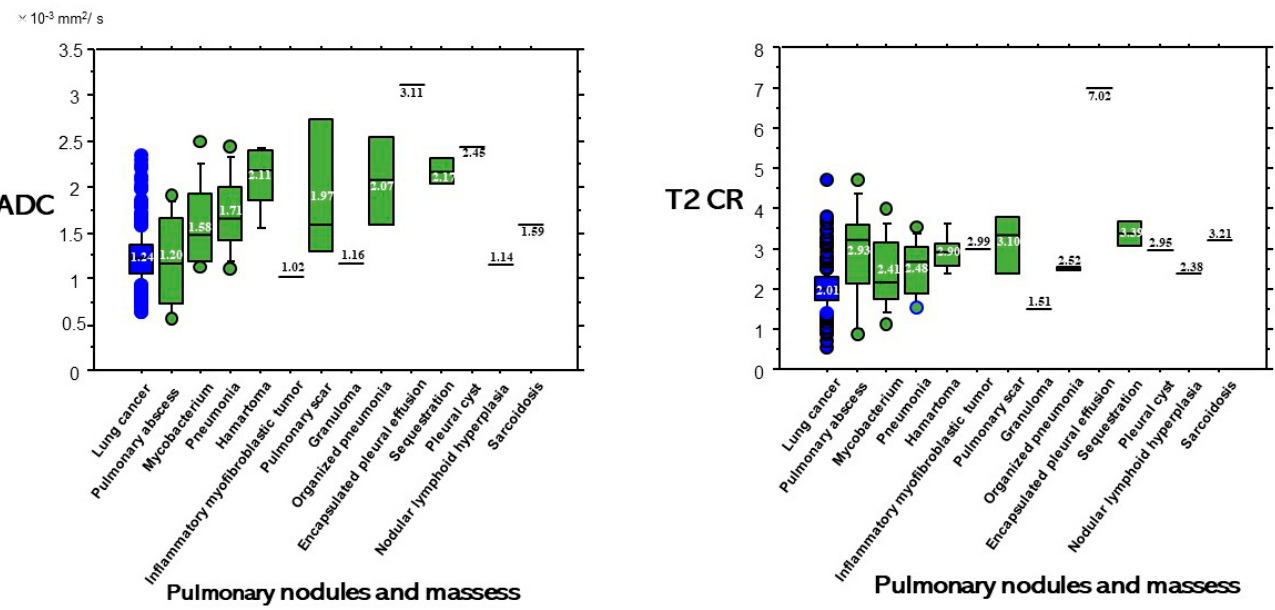
Figure 7. The ADC (1.20 ± 0.53 × 10 − 3 mm 2 /s) of pulmonary abscesses was not significantly lower than that (1.24 ± 0.29 × 10 − 3 mm 2 /s) of lung cancers ( p = 0.695). The ADC (1.58 ± 0.47 × 10 − 3 mm 2 /s) of mycobacterial infections was significantly higher than that (1.24 ± 0.29 × 10 − 3 mm 2 /s) of lung cancers ( p < 0.0001). The T2 CR (2.93 ± 1.26) of pulmonary abscesses was significantly higher than that (2.01 ± 0.52) of lung cancers ( p = 0.010) and the T2 CR (2.41 ± 0.86) of mycobacterial infections was significantly higher than (2.01 ± 0.52) of lung cancers ( p = 0.010).